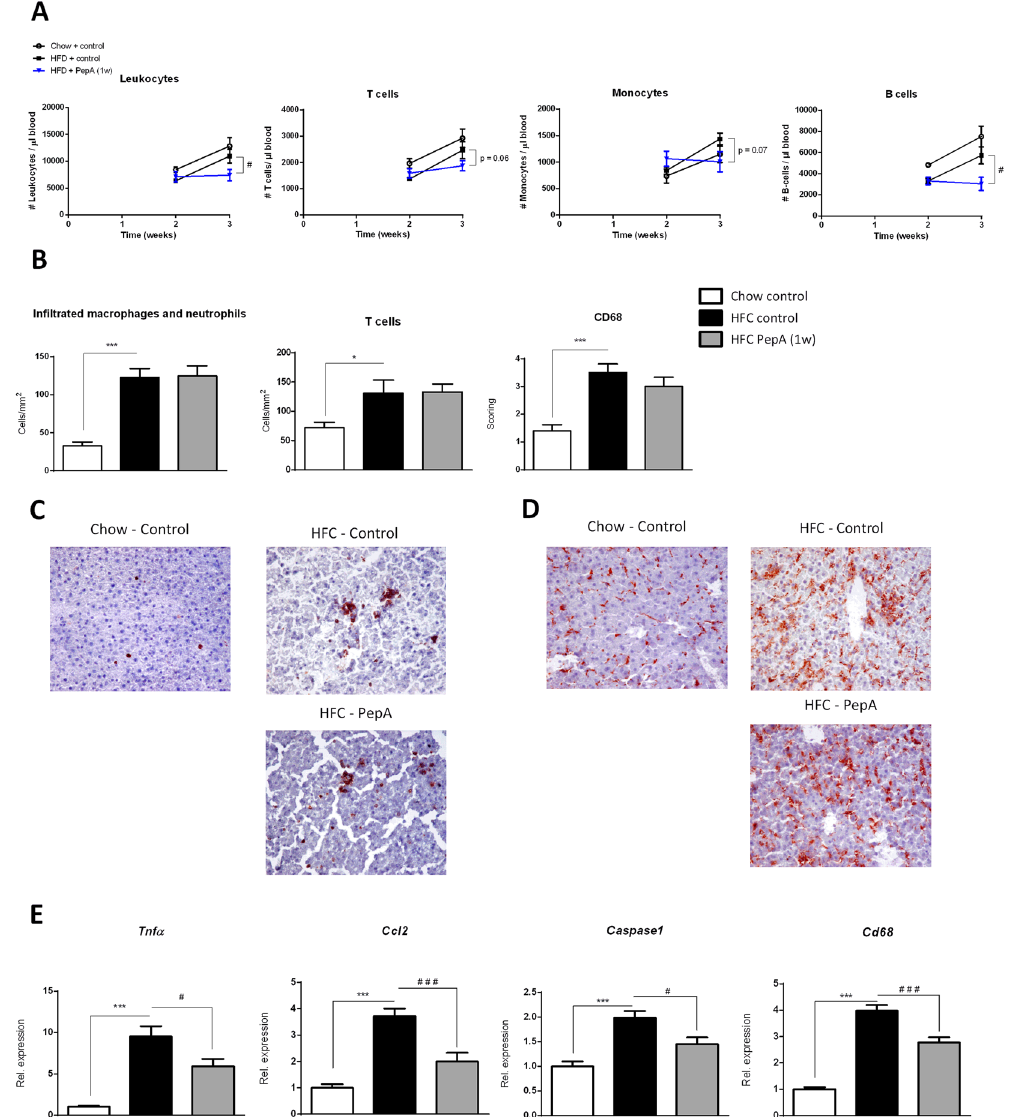
Figure 1. Parameters of systemic and hepatic inflammation in control- and PepA-injected mice. ( A ) Absolute levels of leukocyte, T cell, monocyte and B cell populations at week 2 and 3 of the experiment. ( B ) Liver sections were stained for infiltrating macrophages and neutrophils (Mac-1), T cells (CD3) and resident monocytes/ macrophages (CD68). Positive cells were counted (infiltrated macrophages/neutrophils and T cells) or scored (CD68). ( C,D ) Representative pictures of the Mac-1 ( C ) and CD68 staining ( D ) (original magnification, 200x). ( E ) Gene expression analysis of Tnf α , Ccl2 , Caspase1 and Cd68 . Data are shown relative to control mice on chow diet. Error bars represent ± SEM; * indicates p ≤ 0.05 and *** p < 0.001 compared to mice on chow diet; # indicates p ≤ 0.05 and ### p < 0.001 compared to control-injected mice on HFC diet by use of two-tailed unpaired t test; for FACS n = 4 animals per group and for immunohistochemistry and gene expression n = 8–11 animals per